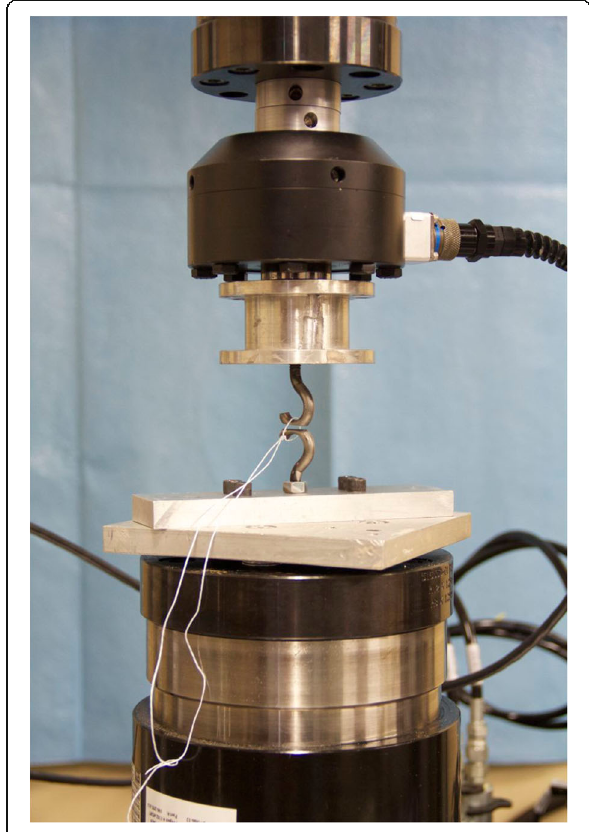
Fig. 1 Testing Apparatus. MTS Bionix Servohydraulic Test Frame with suture located between two